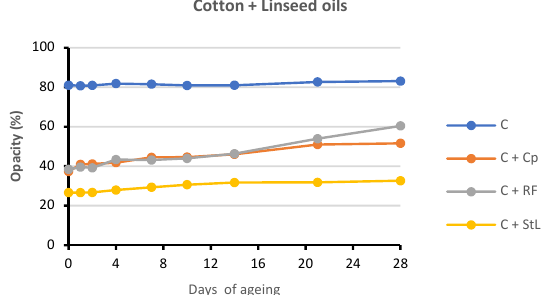
Figure 4. Graph representing the opacity changes of all sets of mock-ups.